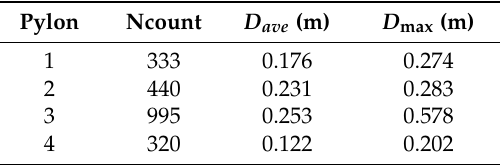
Table 7. Pylon head reconstruction accuracy.